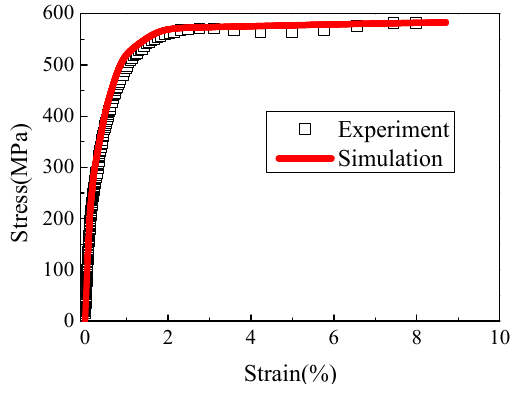
Figure 8. Simulation of uniaxial tension.